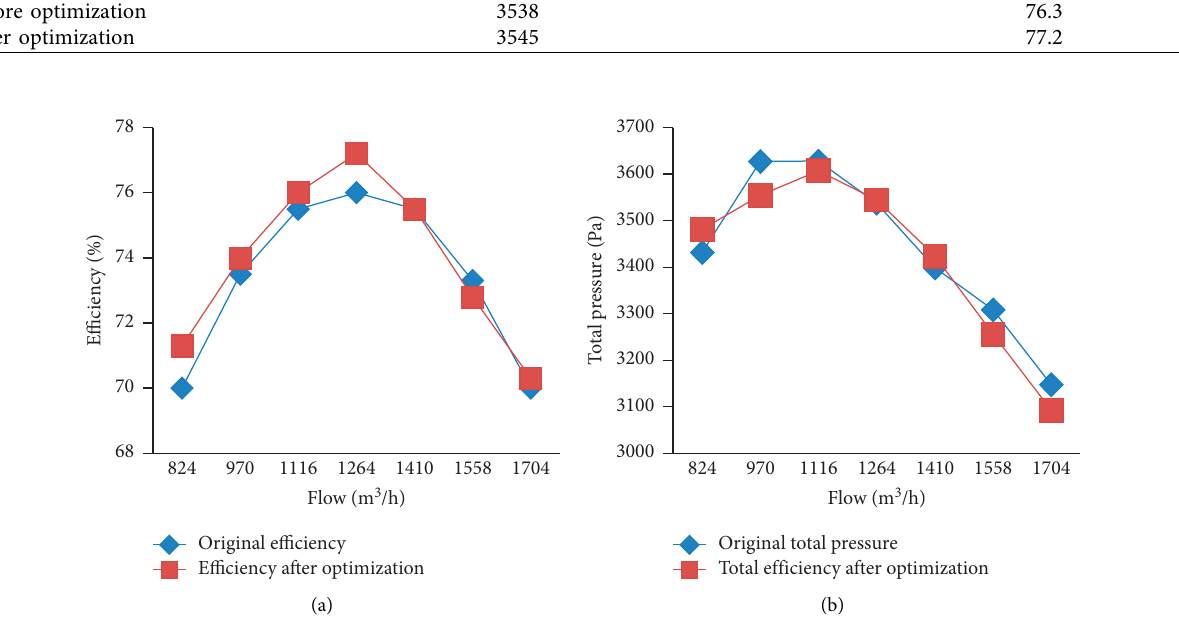
Velocity w Contour 1 6.424e+001